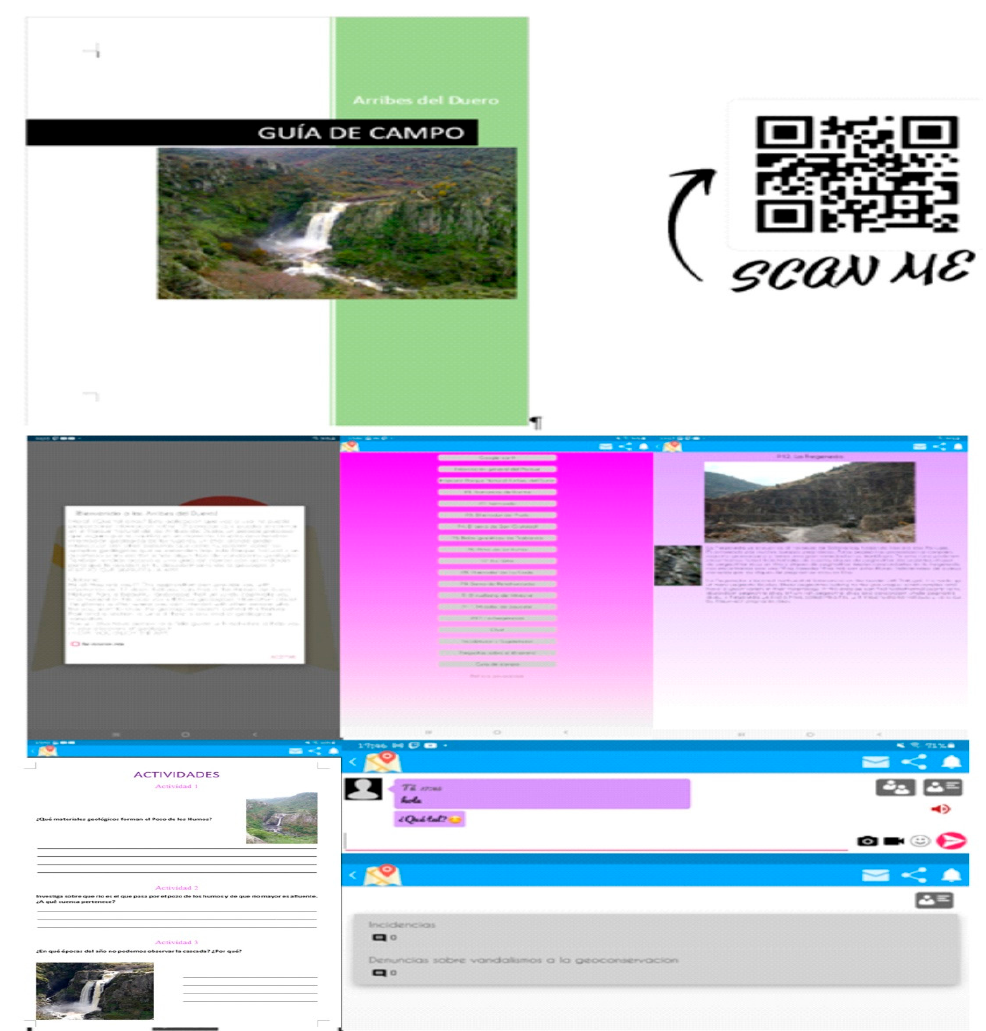
Figure 12. Cover page of field guide and QR code. Screenshots of the geoapp: in the first screenshot there is the welcome message, both of them are in English and in Spanish, the different sections that the app has, the content of stop 12 (La Fregeneda), both of them in English and Spanish, and the group chat and the section on incidents and suggestions.